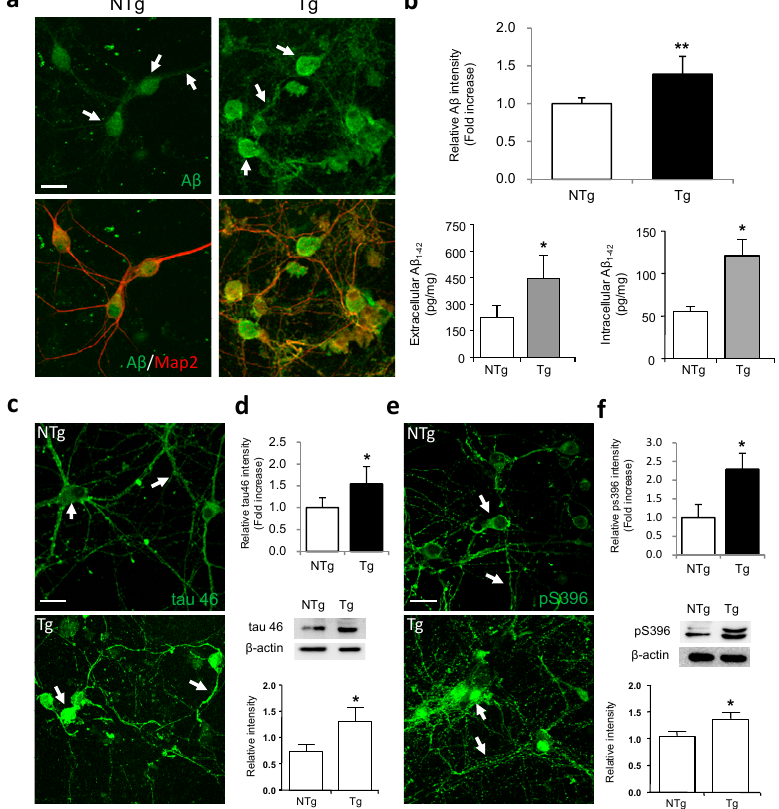
Figure 1. The overexpression of amyloid- β peptide (A β ), tau and phosphorylated tau in 3× transgenic (Tg)-Alzheimer’s disease (AD) neurons. ( a ) Double-labeling analysis of neuronal marker microtubule-associated protein 2 (MAP2) with A β in neurons from nontransgenic (NTg) and Tg neurons. Tg cells showed an overexpression of A β in the soma and neurites as compared to NTg controls (white arrows); ( b ) Quantification revealed a significant difference in A β staining between Tg and NTg neurons. The enzyme linked immunosorbent assay (ELISA) demonstrated that the levels of extracellular and intracellular A β were higher in Tg neurons; ( c ) Total tau immunoreactivity in NTg and Tg neurons as measured with the tau 46 antibody. The immunoreactivity of tau 46 was more intense in the cell bodies and neuritic fibres of Tg neurons as compared to NTg controls (white arrows); ( d ) Quantification revealed a significant difference in tau 46 staining between Tg and NTg neurons. Western blot assay demonstrated that the level of total tau was significantly higher in Tg neurons; ( e ) Phosphorylated tau immunoreactivity in NTg and Tg neurons as measured with the phospho-tau (Ptau) antibody pS396. Tg neurons showed intense pS396 staining in the cytoplasm and neurites as compared to NTg controls (white arrows); ( f ) Quantification revealed a significant difference in pS396 staining between Tg and NTg neurons. Western blot assay demonstrated that the level of Ptau-396 was higher in Tg neurons. Bars graph (means ± SD) represented three independent experiments. * p < 0.05, ** p < 0.01. Scale bars in ( a , c , e ) = 20 μ m.